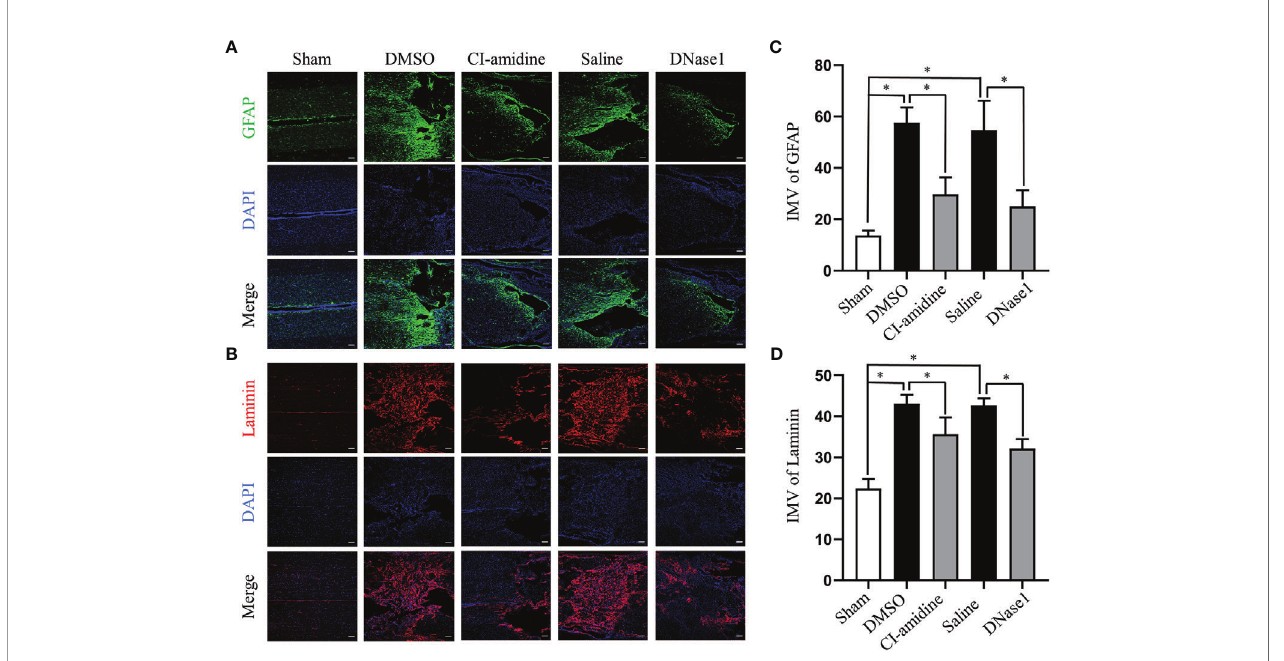
FIGURE 6 | Restricting NETs reduces both glial and fi brotic scar formation after SCI. (A) Representative images of GFAP (green) positive glial scar in injured spinal cord of each group at 28 days after operation. Nuclear was marked with DAPI (blue). (B) Representative images of Laminin (red) positive fi brotic scar in injured spinal cord of each group at 28 days after operation. Nuclear was marked with DAPI (blue). Scale bars = 100 m m. Fluorescence intensity mean value (IMV) of (C) GFAP and (D) Laminin at the injury epicenter of each group. Data are presented as means ± SD of n = 6 (* p < 0.05).